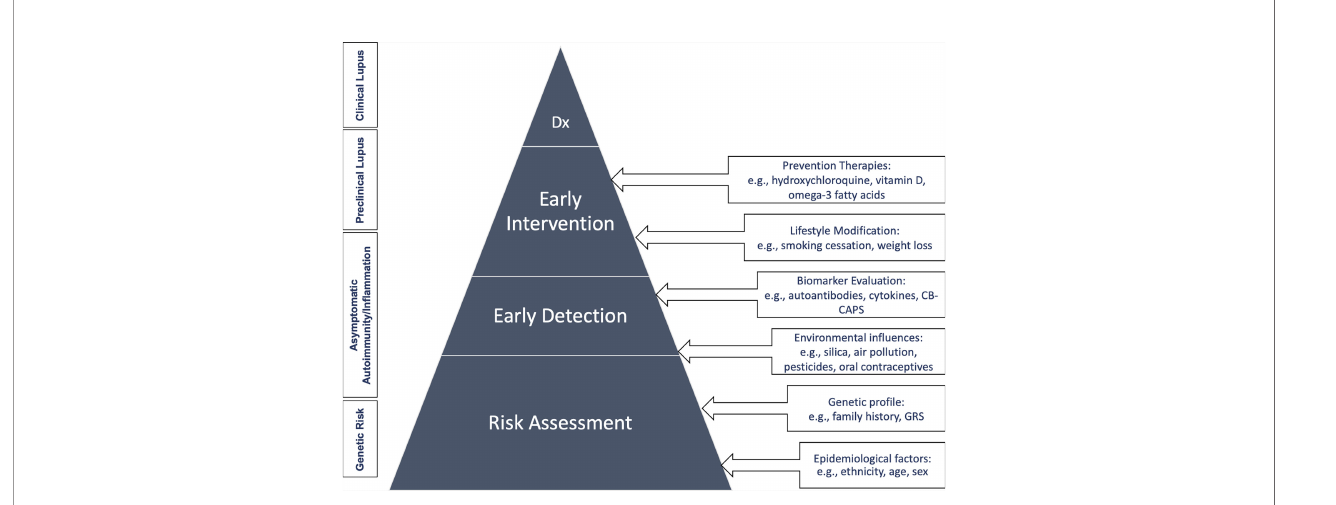
FIGURE 2 | Clinical care pathway for the screening and prevention of SLE. Dx, diagnosis; GRS, genetic risk